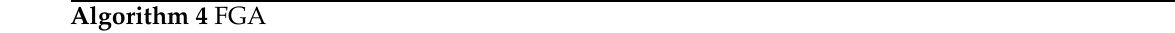
Algorithm 4 FGA